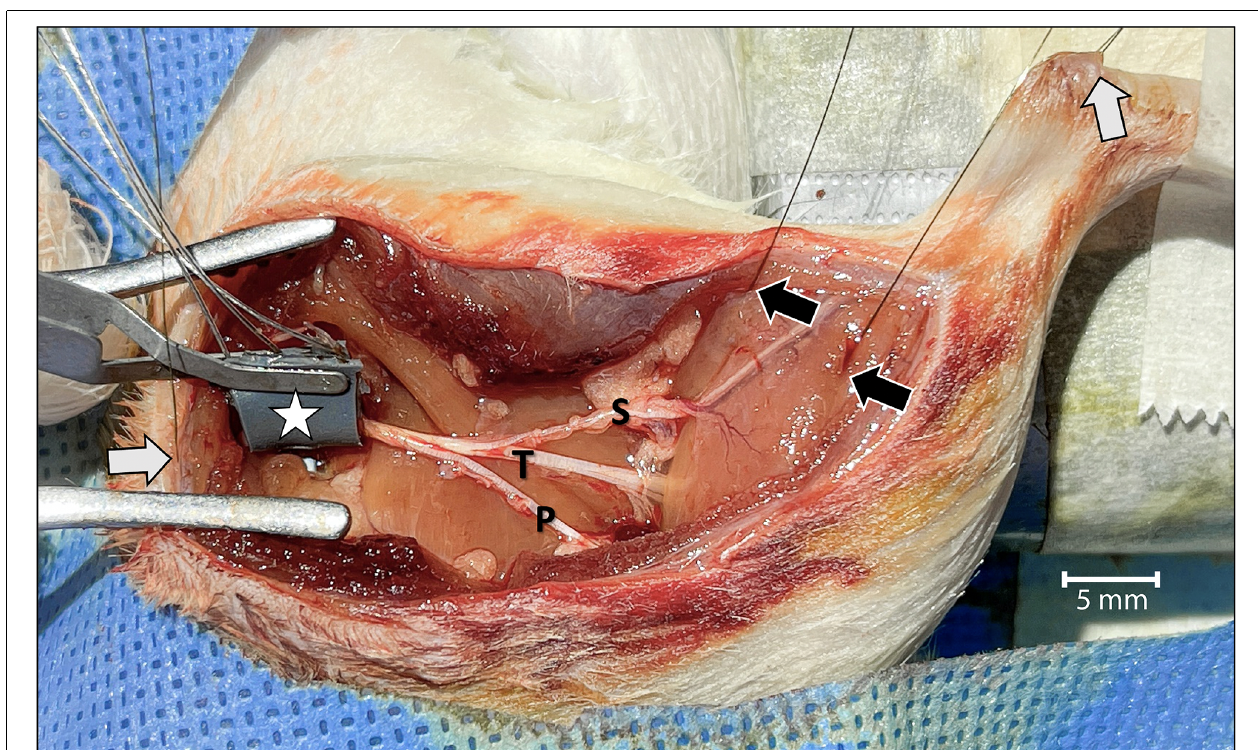
FIGURE 1 | Surgical view of the left leg showing the acute dissection and the methods used to establish two-channel CMAP recording and nerve stimulation. Wire-hook recording electrodes were inserted into the belly of the lateral and medial gastrocnemius muscles (black arrows) and Achilles tendon (white arrow in the upper right). A grounding electrode was placed under the skin of the back of the rat (white arrow on the left). The bipolar stimulating nerve cuff electrode with its connecting wires was wrapped around the proximal sciatic nerve at the level of the sciatic notch (star). To isolate motor unit activation corresponding only to the tibial (T) nerve, and to prevent signal interference, the sural (S) and peroneal (P) nerves were cut. The tibial nerve was crushed just distal to the point of sural nerve take-off. For orientation, the rostral direction is down to the